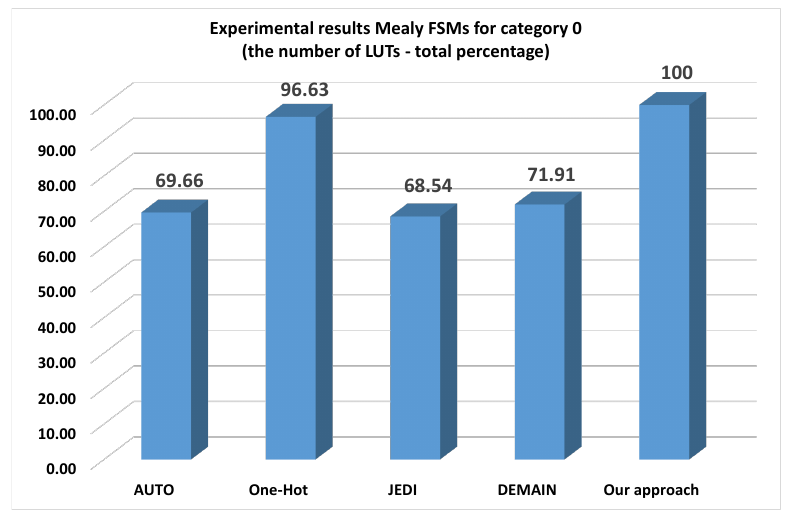
Figure 9. Experimental results for category 0 (the number of LUTs—total percentage).